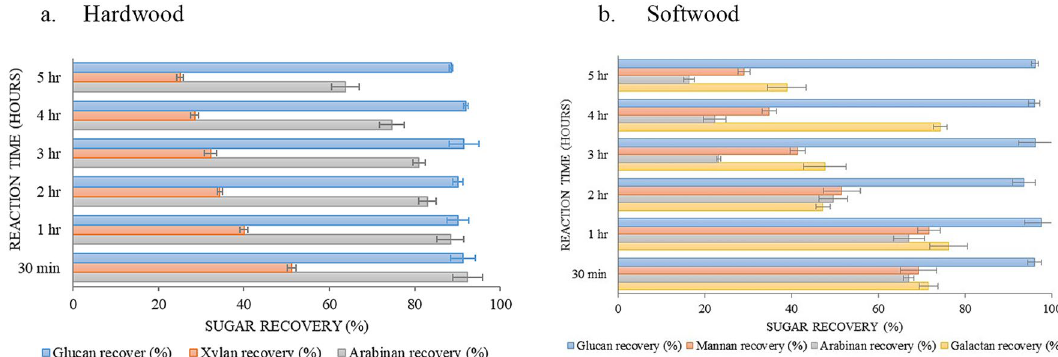
Figure 1. Carbohydrate recovery rates after the acid